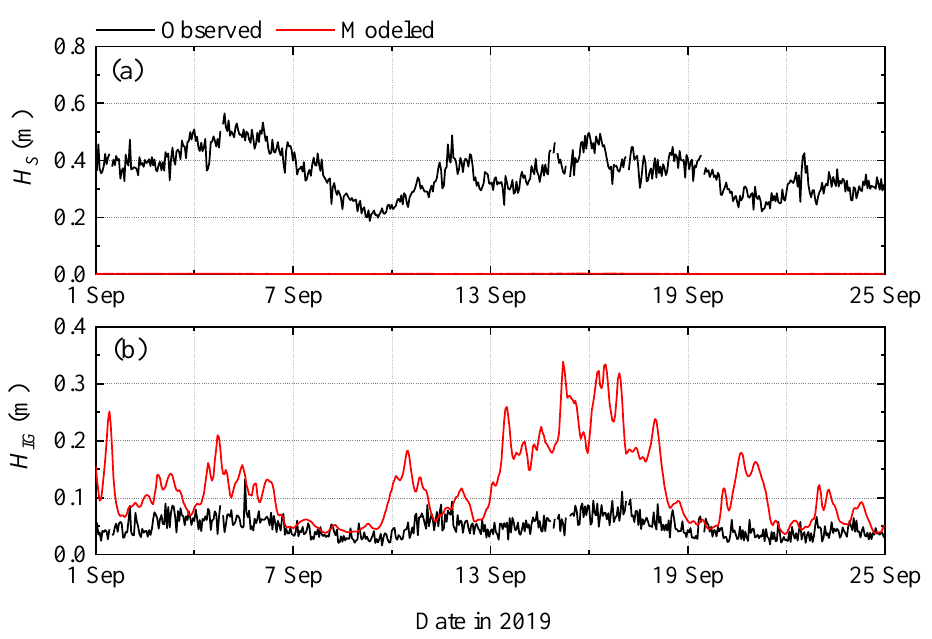
Figure 7. Modeled (red) and observed (black) wave heights 1–25 September 2019, at the location of sensor G3: ( a ) significant wave height H S and ( b ) significant IG wave height H IG . Table 5. Performance statistics of XB-SB at the location of sensor G3. CC